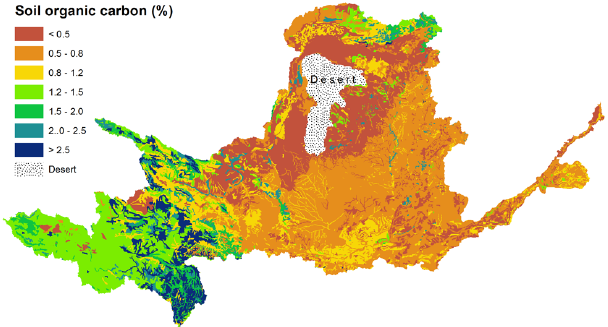
Fig. 4. Spatial variability of soil organic carbon in the Yellow River basin. Data are from the Environmental and Ecological Science Data Center for West China